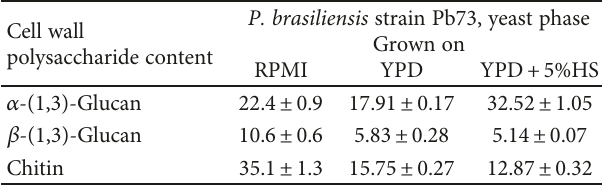
Figure 1: Silencing of Pb AMY1 reduces α -(1,3)-glucan of P. brasiliensis yeast cell. (a) Semiqualitative estimation of α -(1,3)-glucan on Paracoccidioides yeast cells by immuno fl uorescence. Pseudocolor mask for saturation (ImageJ). (b) Quanti fi cation of α -(1,3)-glucan in Paracoccidioides yeast cells by anthrone assay. ∗∗∗∗ P < 0 00001 , Welch ’ s test. Table 2: Relative content of the main polysaccharides present in the yeast cell wall of Paracoccidioides brasiliensis strain Pb73 yeast cells, grown on di ff erent culture media for 4 days at 37 ° C. HS, horse